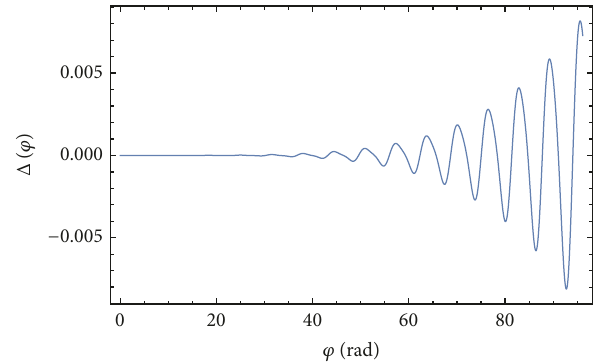
Figure 2: The absolute difference Δ(𝜑) between the numerical solution 𝑈(𝜑)| num and the truncated Laplace-Adomian power series solution 𝑈(𝜑)| LADM of (80) for 𝑏 2 = 0.0225 and 𝑎 = 0.001 .